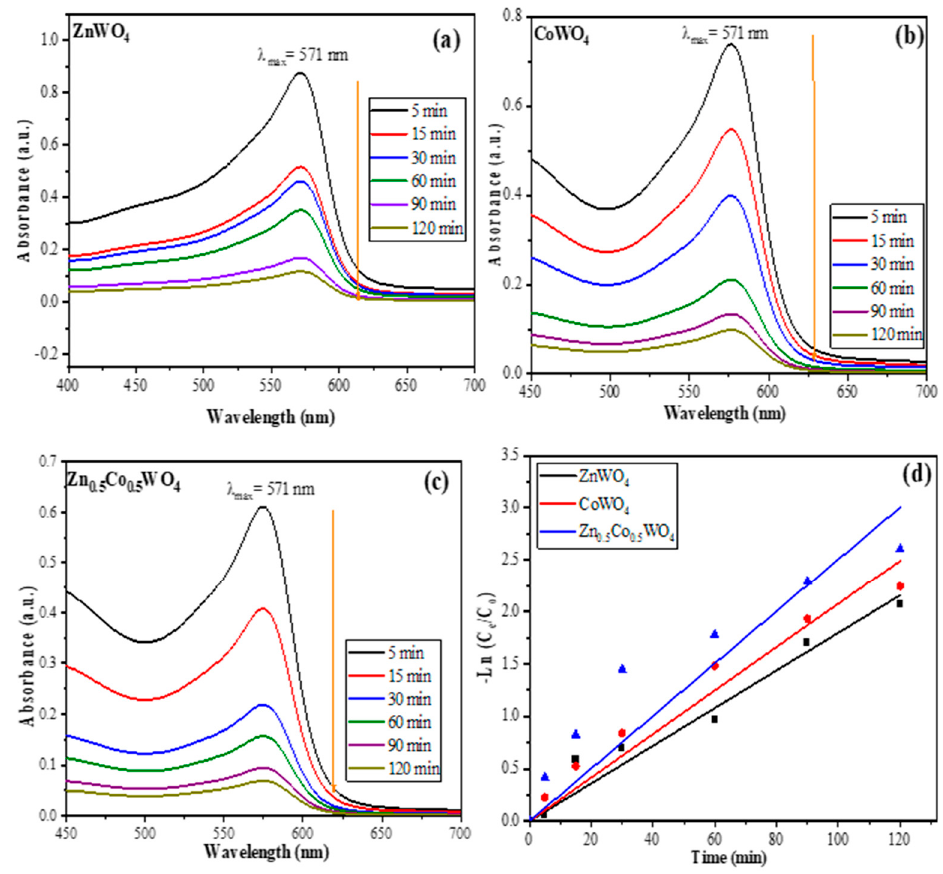
Figure 10. UV–vis absorption spectra of degraded XO dye (60 ppm) using 10 mg of ( a ) ZnWO 4 ; ( b ) CoWO 4 ; ( c ) Zn 0.5 Co 0.5 WO 4 ; and ( d ) L–H model pseudo-first-order kinetic graph with variable irradiation time (5–120 min). Table 2. The kinetic parameters for the degradation of XO dye (20ppm) using 10 mg ZnWO 4 ,